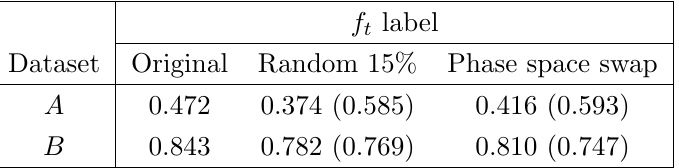
Table 4 . Labels for the fractions of the two datasets used when the data is mismodeled. The numbers in parenthesis show the true fraction contained in the